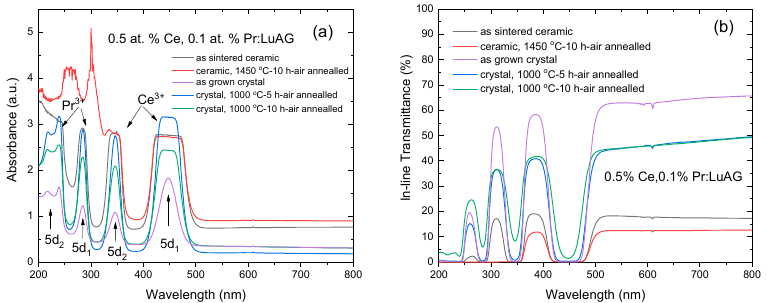
Figure 5. Absorbance spectra ( a ) and in line transmittance ( b ) of the as grown Ce, Pr:LuAG crystals